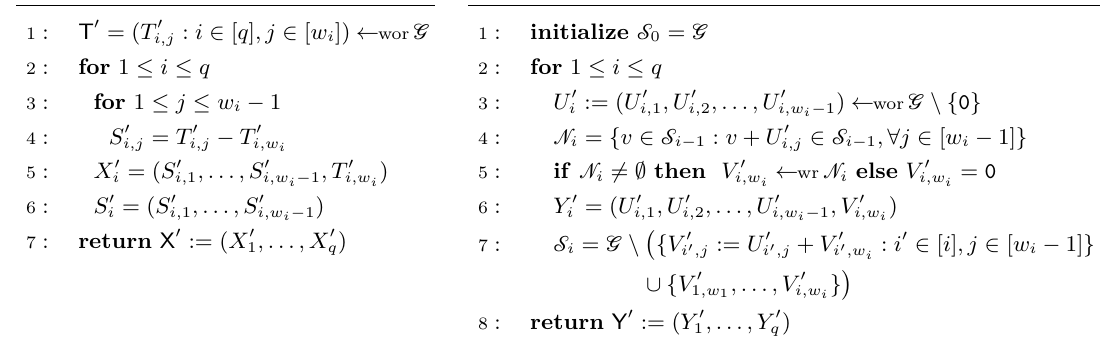
Figure 3.4: X ’ and Y ’ are extended random variables of S 0 and U 0 respectively. These are similarly defined as in the fixed width